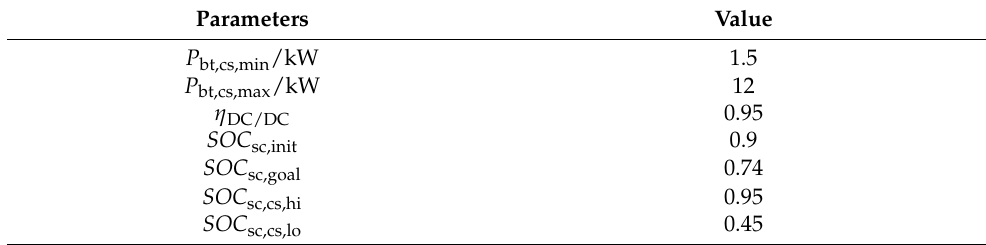
Table 5. The optimal energy control strategy parameters. Parameters